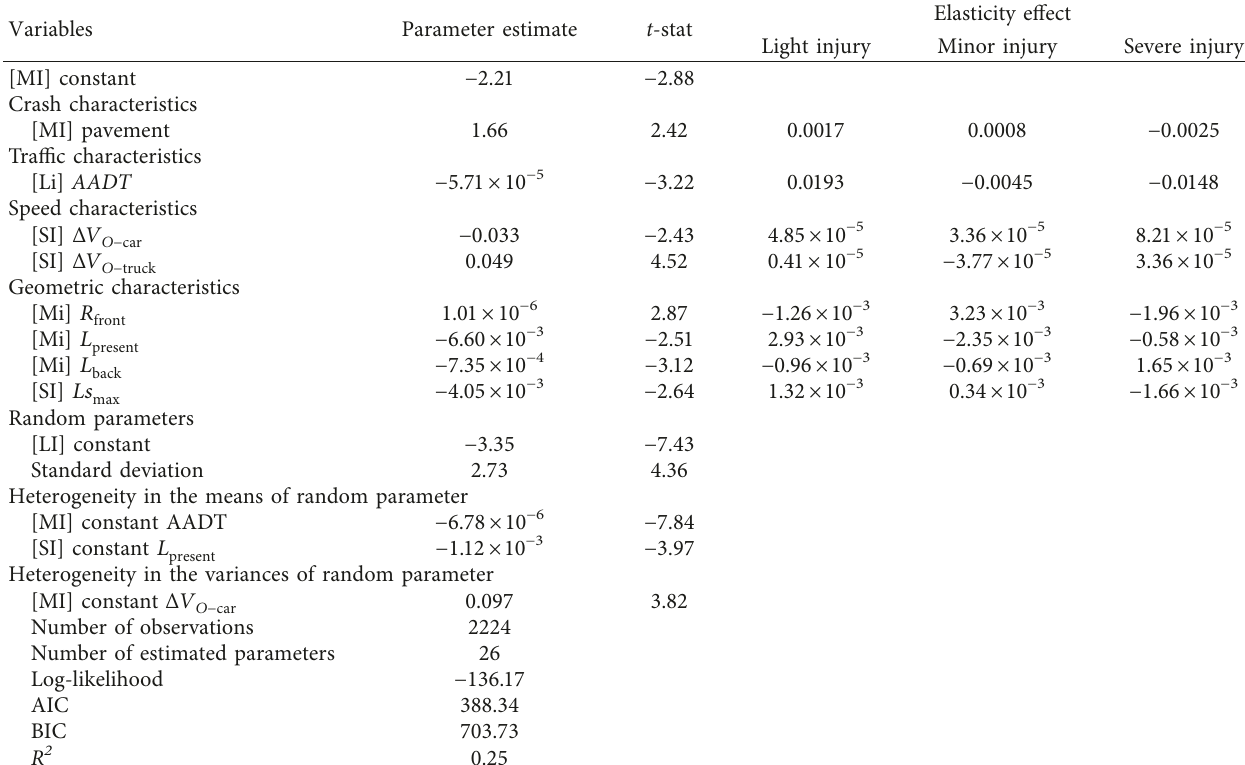
Table 6: Model results of the random parameter logit model with heterogeneity in means and variance for daytime crashes.